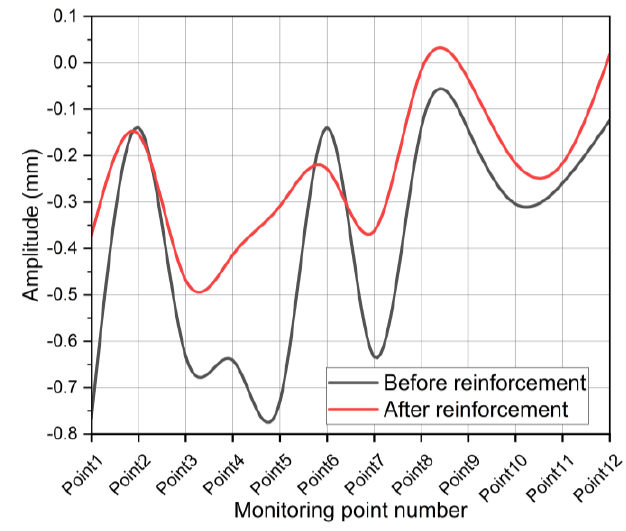
Figure 15. Average amplitude before and after